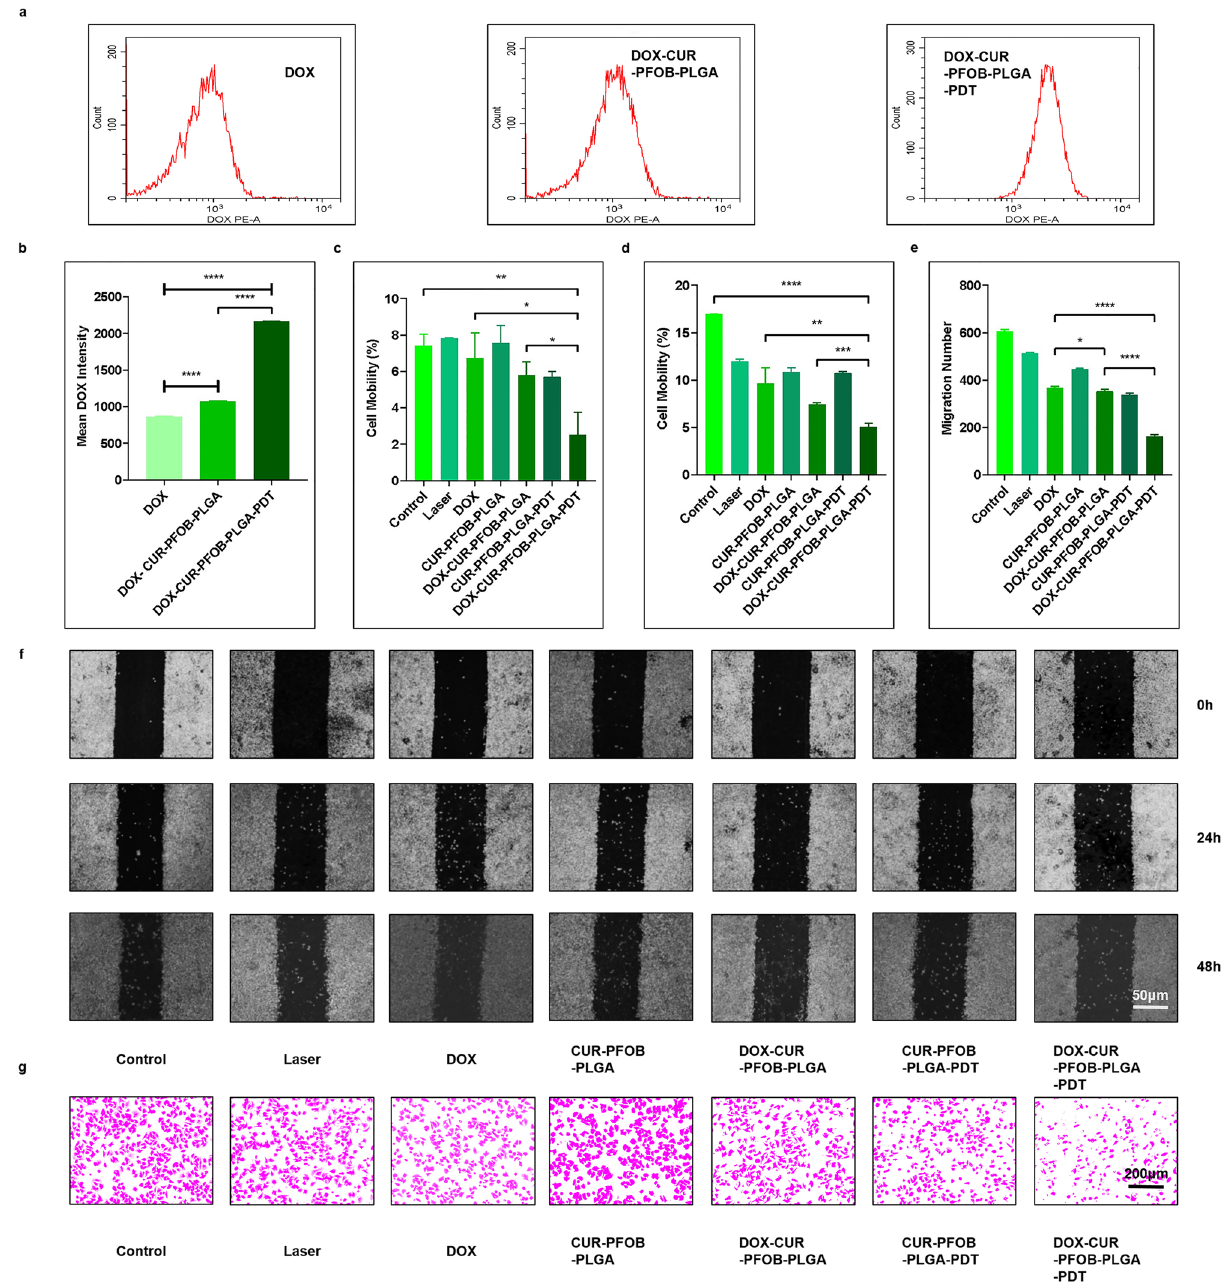
Figure 5. Examination of intracellular uptake and migration characteristics of MCF-7 cells. ( a ) FCM detection of intracellular DOX fluorescence intensity; ( b ) Statistics of DOX fluorescence intensity; ( c ) Statistics of MCF-7 cell mobility at 24 h; ( d ) Statistics of MCF-7 cell mobility at 48 h; ( e ) Statistics of MCF-7 cell migration numbers; ( f ) Images of MCF-7 wound scratches under inverted fluorescence microscope at 0 h, 24 h and 48 h; ( g ) Images of crystal violet staining of migrating cells under inverted fluorescence microscope. All statistics above were analyzed by Image J 1.46 r (https:// imagej. nih. gov/ ij/ docs/ guide/ 146. html) and GraphPad Prism 8.0 (https:// www. graph pad. com/ updat es), * P < 0.05; ** P < 0.01; *** P < 0.001; **** P <